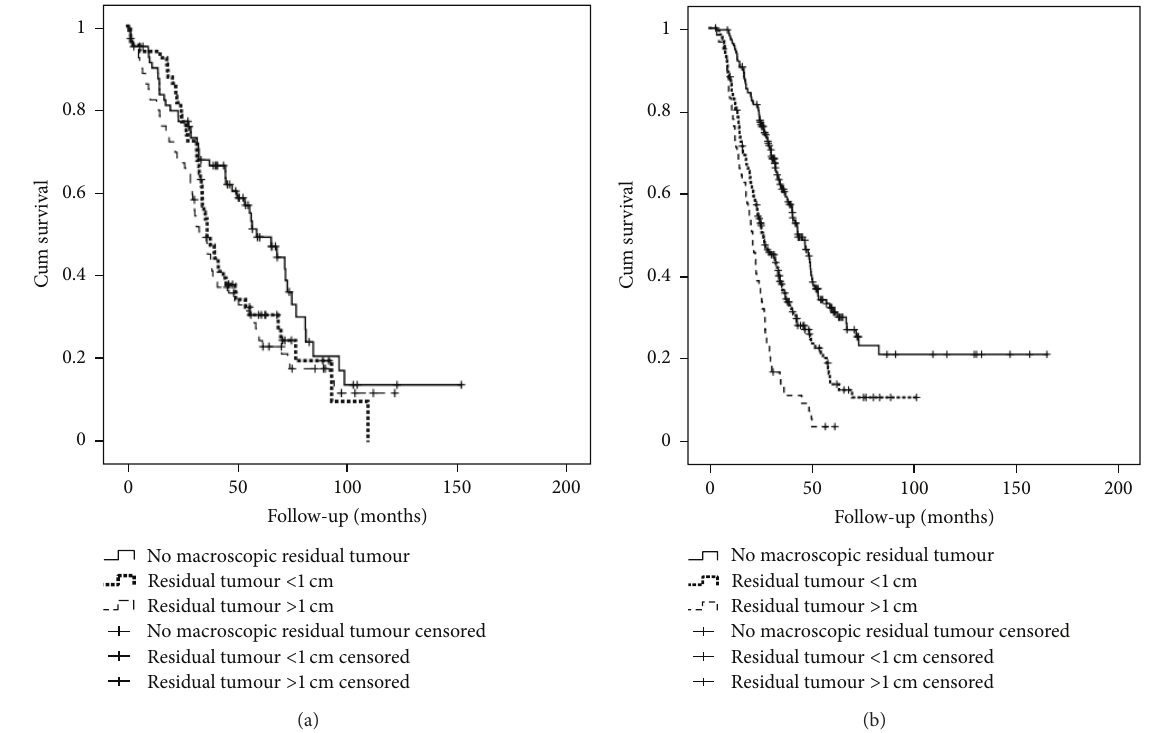
Figure 1: Disease specific survival according to surgery result for (a) primary debulking surgery (PDS) and (b) interval debulking surgery